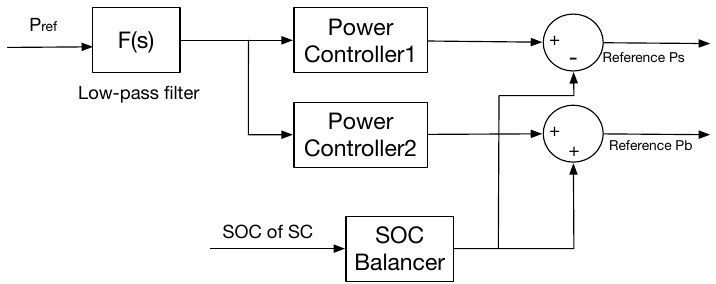
Figure 6. Control block diagram of energy management